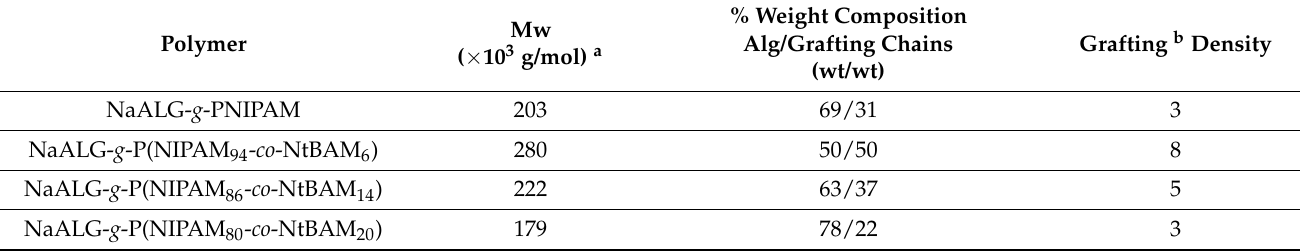
Table 2. Molecular characteristics of the graft copolymers from 1 H